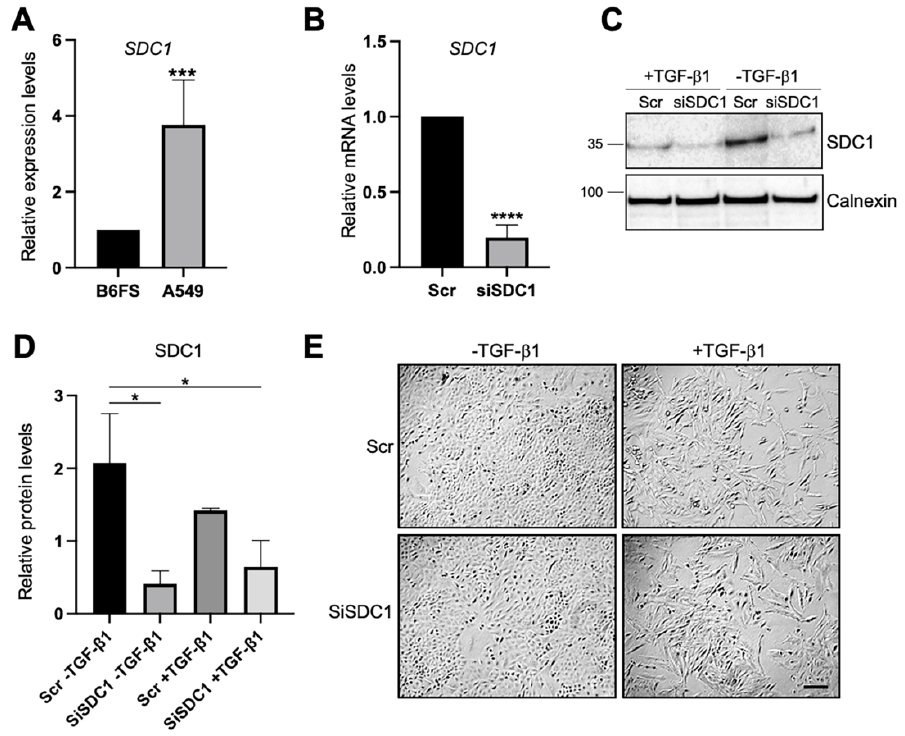
Figure 1. Knockdown of SDC1 during TGF- β 1-induced EMT in A549 cells. ( A ) Bar graph showing relative SDC1 mRNA expression in A549 cells compared to B6FS cells. Values were normalized to GAPDH and B6FS cells. ( B ) qPCR results showing SDC1 mRNA levels in A549 cells transfected with SDC1 siRNA (siSDC1) compared to scrambled siRNA (Scr). ( C ) Western blot results showing the effect of SDC1 knockdown and TGF-β1 treatment (10 ng/mL, 72 h) on SDC1 protein levels. Calnexin was used as a loading control. ( D ) Bar graph showing quantification of western blot results. ( E ) Brightfield images showing morphological changes characteristic of EMT in A549 cells transfected with Scr or SDC1 siRNA and treated with TGF-β1 (10 ng/mL, 48 h). Scale bar = 20µm. * = p < 0.05; *** = p < 0.001; **** = p < 0.0001.